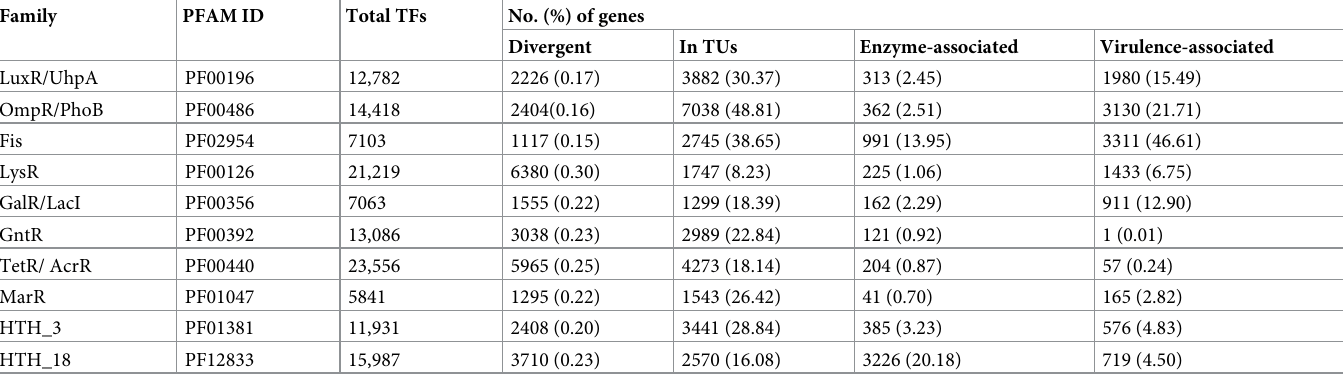
Table 2. Distributions of genes related to the studied protein families.